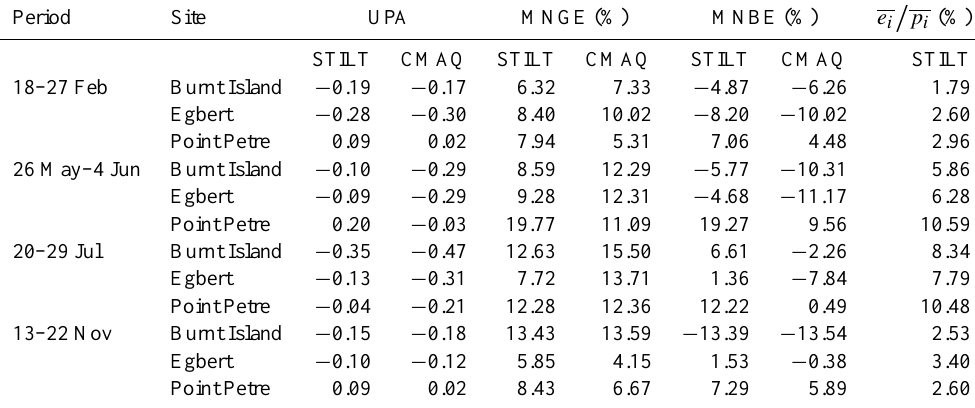
Table 2. Statistics for predicted TGM concentrations using CMAQ and STILT. Period Site